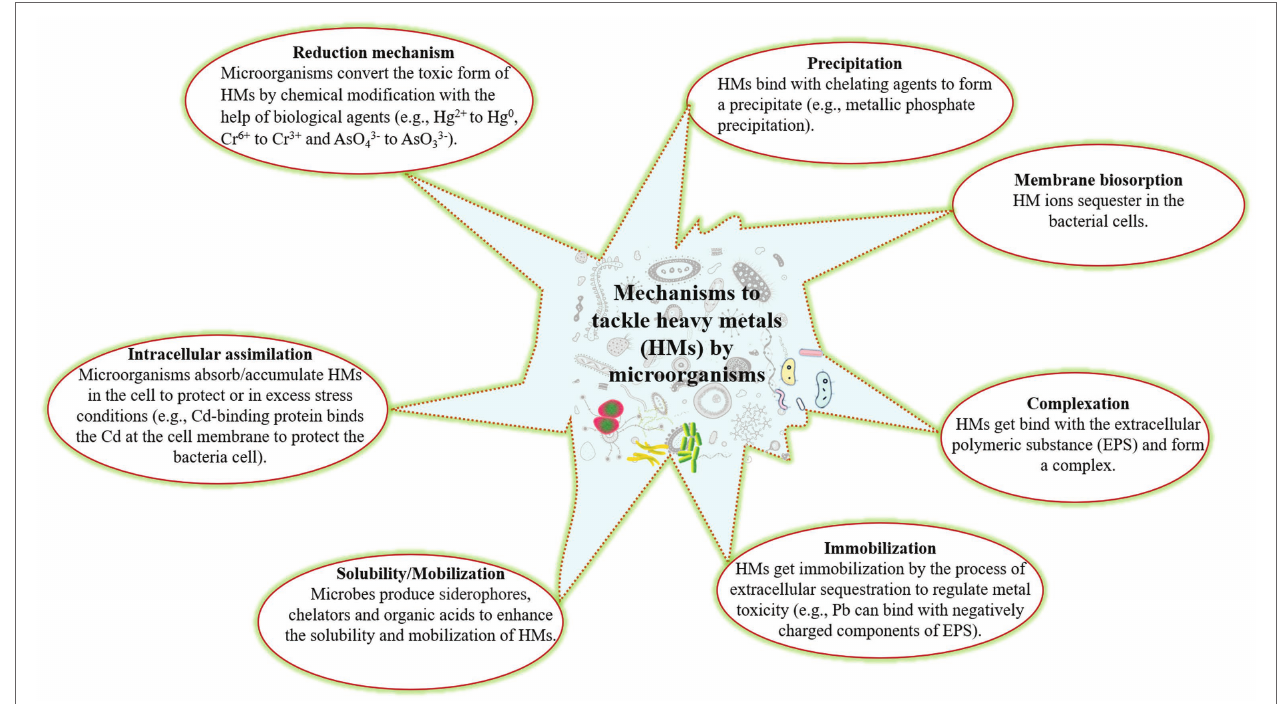
FIGURE 1 | Different microorganisms mechanisms to tackle the HMs from the